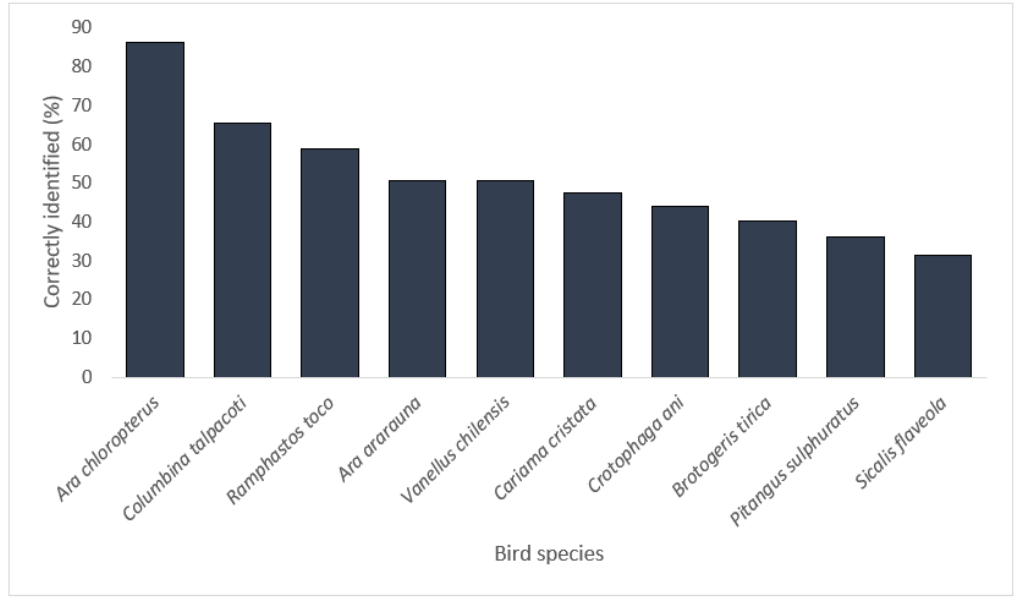
Figure 2. Percentage of individuals correctly identifying each of 10 bird species encountered in Rondonópolis.